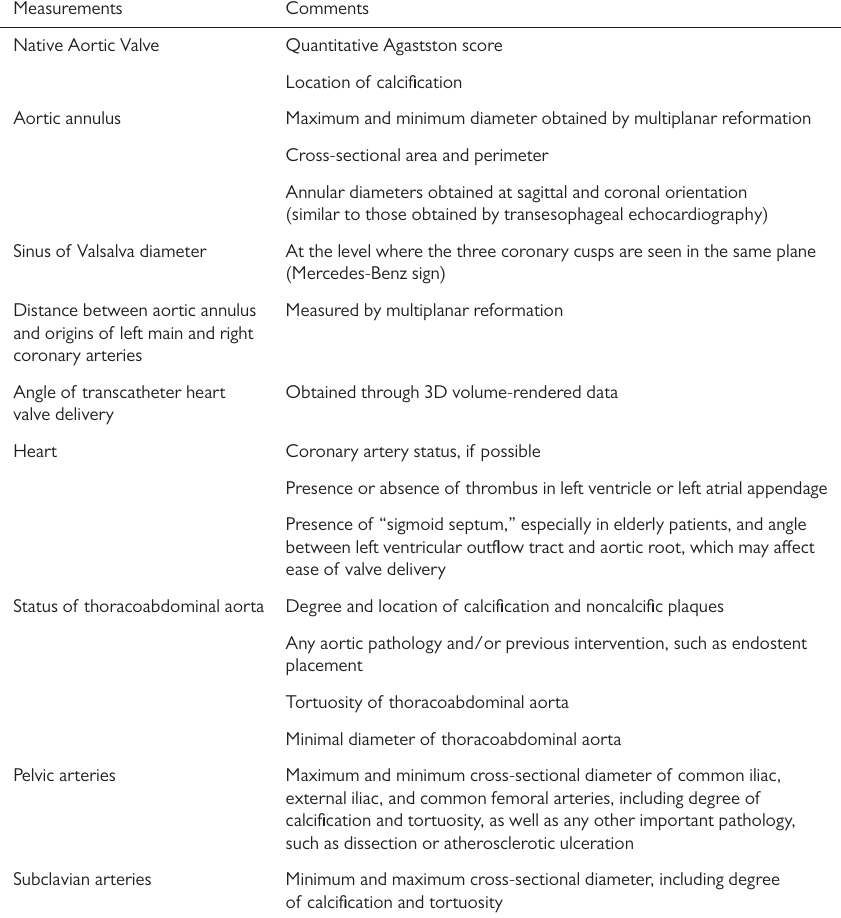
Table 2. Important measurements obtained with multidetector computed tomography angiography Measurements